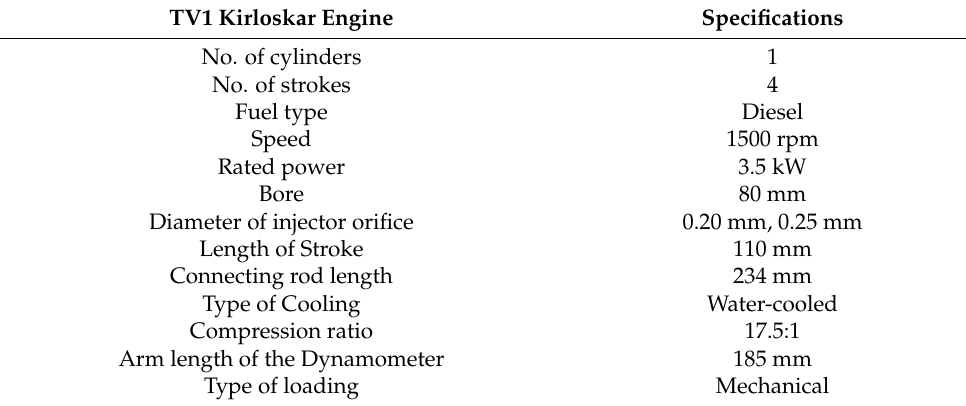
Table 3. Test engine’s specifications